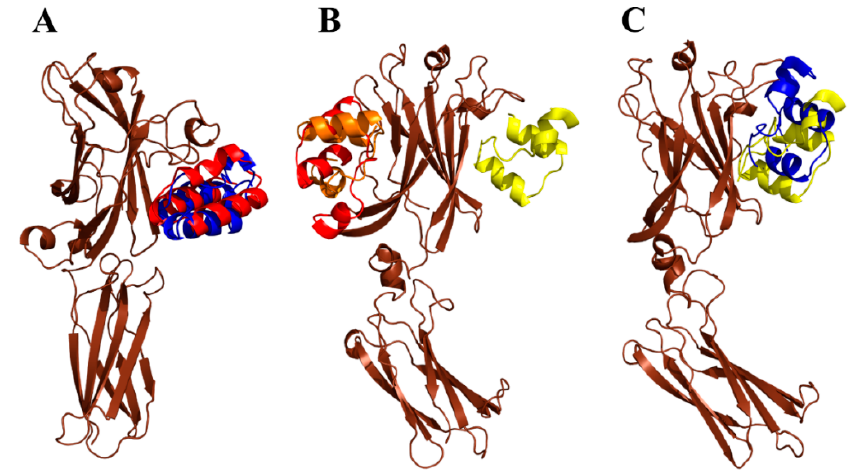
Figure 9. Structural effect of amino acid alterations in the ABD scaffold. ( A ) The most probable pose of the ARS004/IL-17RA interaction obtained by flexible side chain docking (red, see also Figure 7A) compared to the structure relaxed by 100 ns molecular dynamics simulation ( blue ). ( B ) Modeling of the ARS014/IL-17RA interaction by docking. The initial geometry of ARS014 was obtained from a 1 µ s molecular dynamics simulation. Summary of the first three poses of ARS014 binding to the IL-17RA ( brown ) is shown in decreasing predicted order of probability demonstrated in red (the most probable), orange, and yellow, respectively. ( C ) The third most probable pose ( yellow ) of the ARS014/IL-17RA interaction compared to the structure relaxed by 100 ns molecular dynamics simulation ( blue ).